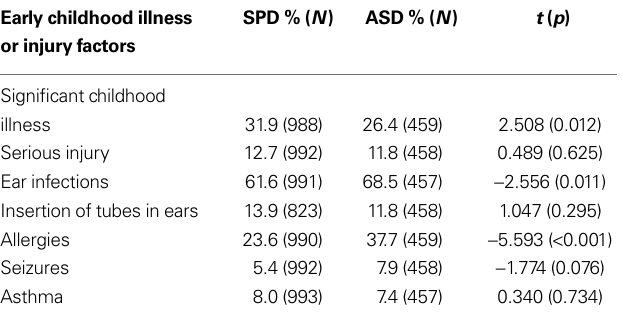
Table 6 | Percentage, valid N , and T -tests for early childhood illnesses and injuries